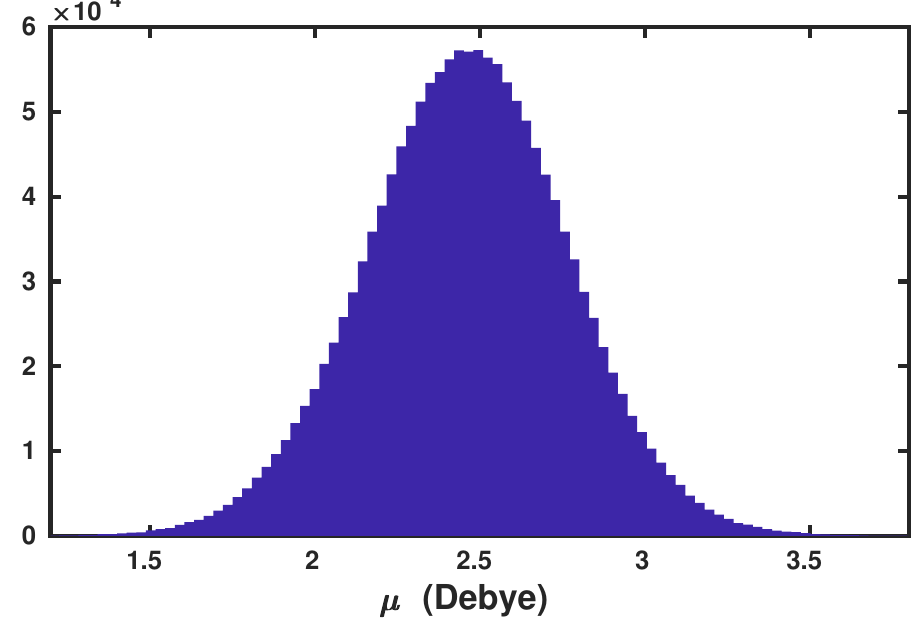
Figure 1. Distribution of molecular dipole moment ( µ ) of water molecules at ambient conditions, as computed using the maximally localized Wannier centers.